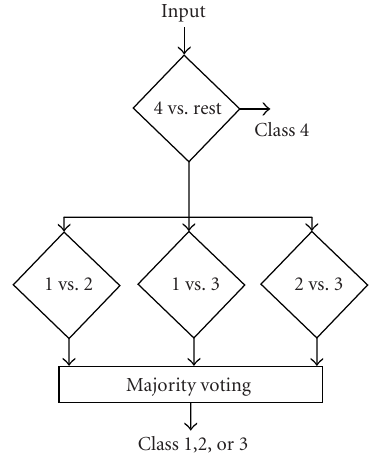
Figure 7: Flow chart showing the decision rights of the collabora- tive committee for the NN